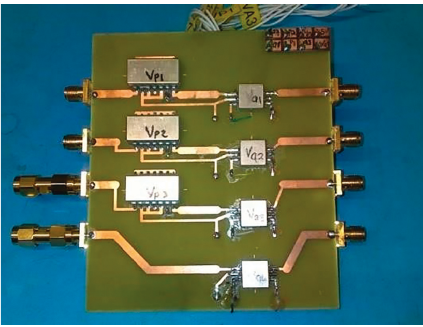
Figure 11: Phase shifter and attenuator circuit [43]. Table 2: Dimensions of dipole antennas [43].